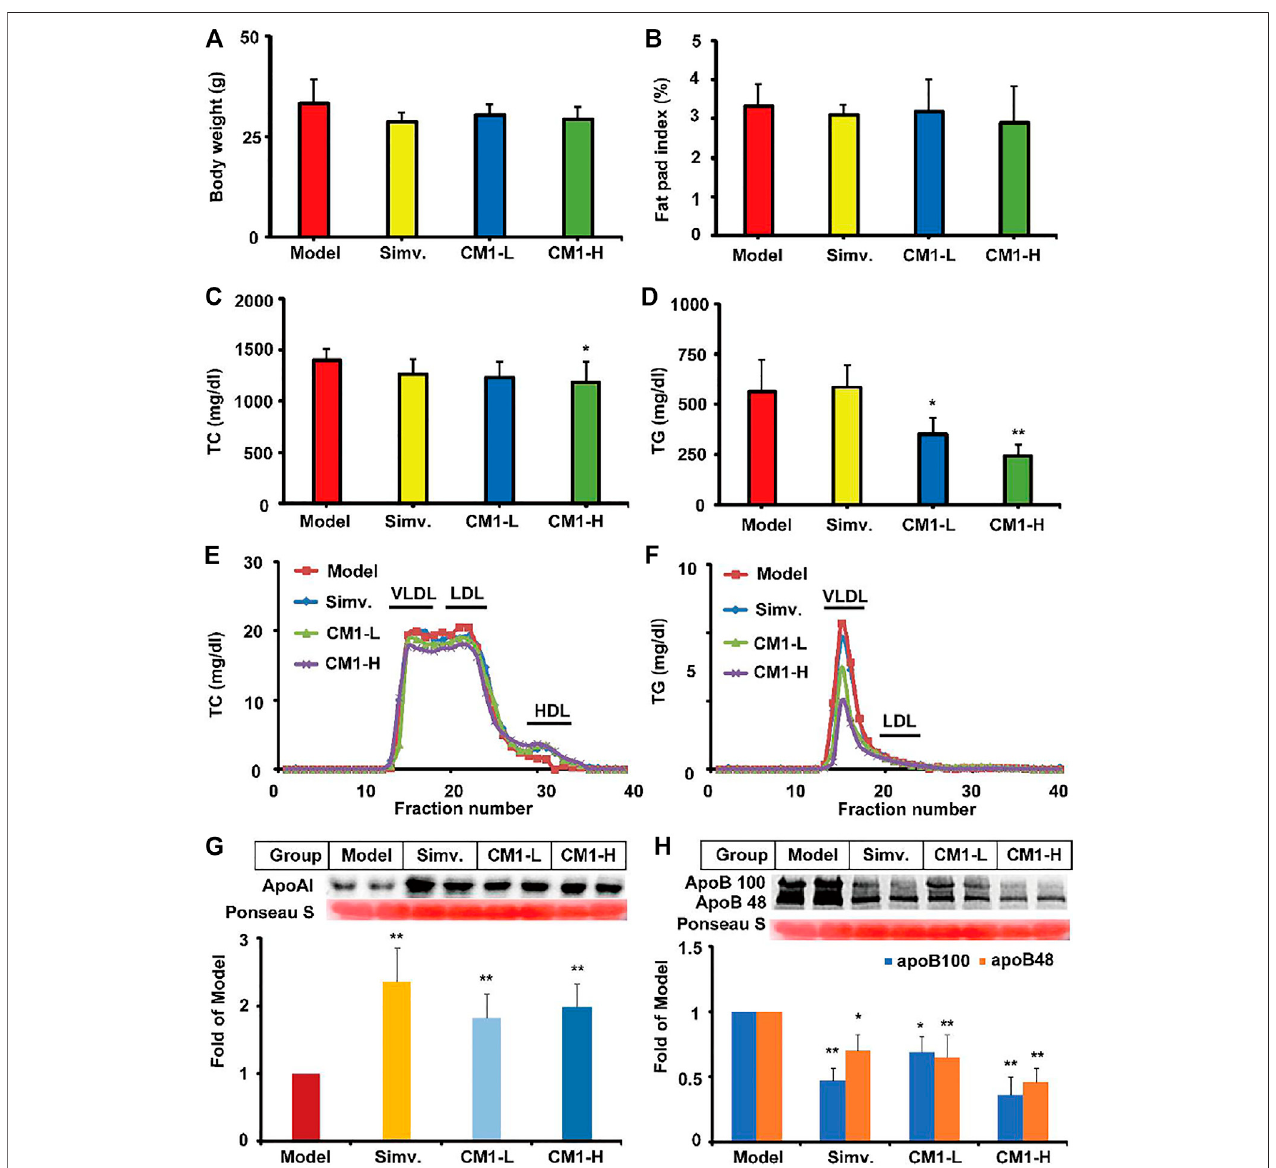
FIGURE 2 | Effect of CM1 on the body weight, fat pad index, plasma lipid pro fi les and expression of apoAI and apoB ( n ≥ 4). (A) , body weight of the mice in each group; (B) , fat pad index of the mice in each group. Fat pad index means the percentage of fat pad to body weight; (C) , plasma TC concentrations; (D) , plasma TG concentrations; (E) , plasma TC pro fi les of the lipoproteins after ÄKTA-FPLC separation; (F) , plasma TG pro fi les of the lipoproteins after ÄKTA-FPLC separation; (G) , plasma apoAI expression and densitometric quanti fi cation; (H) , plasma apoB expression and densitometric quanti fi cation. *means p < 0.05 vs . Model, and **means p < 0.01 vs .